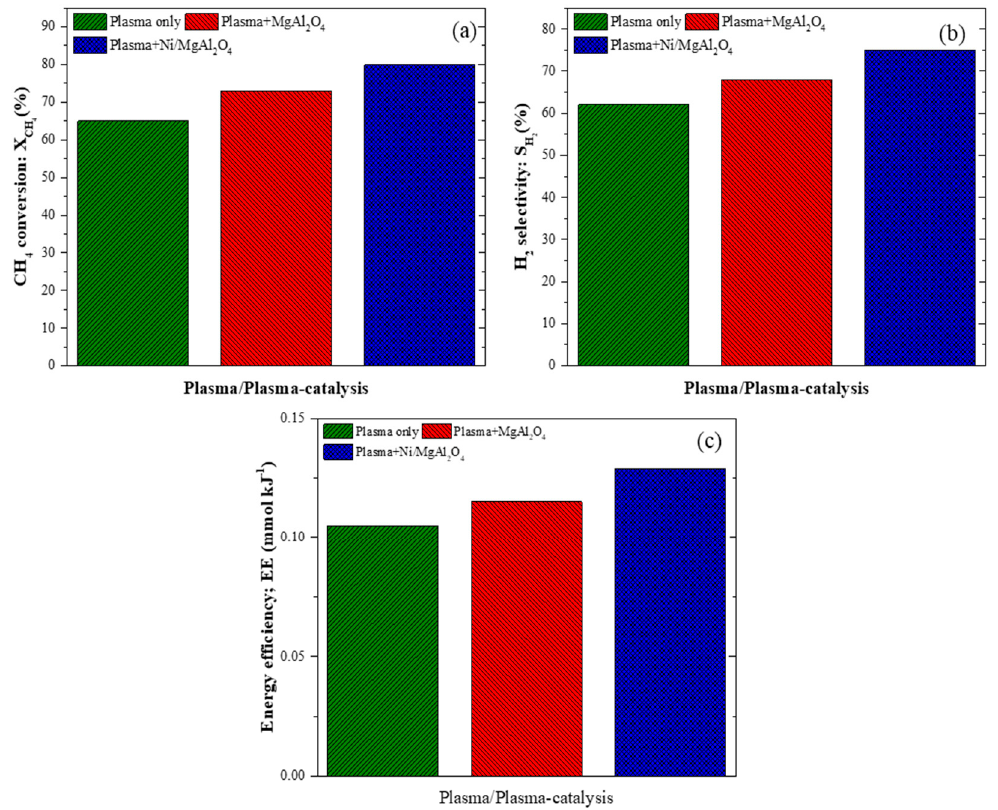
Figure 7. Plasma/plasma-catalyst activity: ( a ) X CH4 conversion ( b ) S H2 selectivity ( c ) EE; GHSV = 364 h − 1 , specific input energy (SIE) = 300 J mL − 1 , loading of catalyst = 0.5 g, T = 350 °C, discharge gap (D gap ) = 03 mm, discharge length (D L ) = 20 cm, discharge volume (V D ) without catalyst: 13.5 cm 3 , V D with catalyst loading = 9.75 cm 3